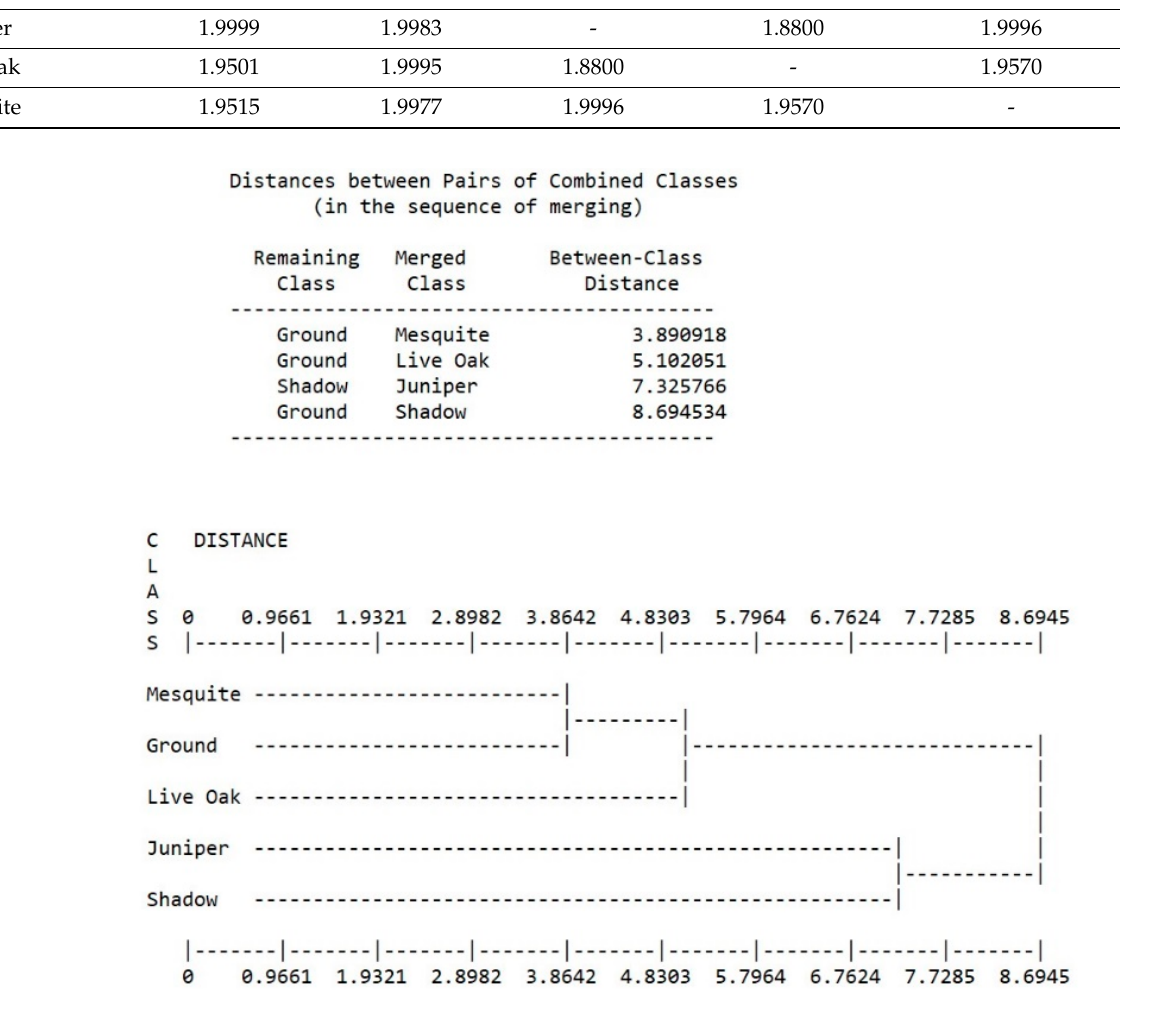
Figure 4. Dendrogram showing clustering and interclass distances for the five training